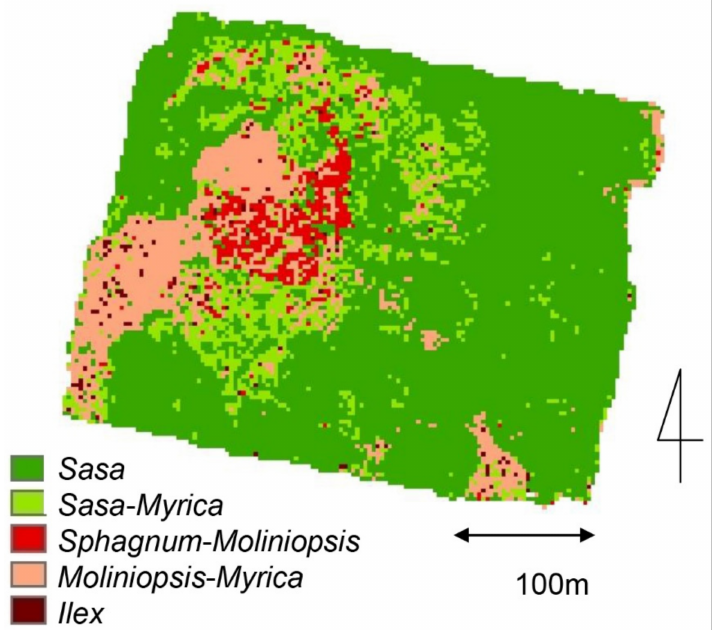
Figure 6. Spatial distribution of vegetation communities in the Bibai Wetland estimated using a satellite